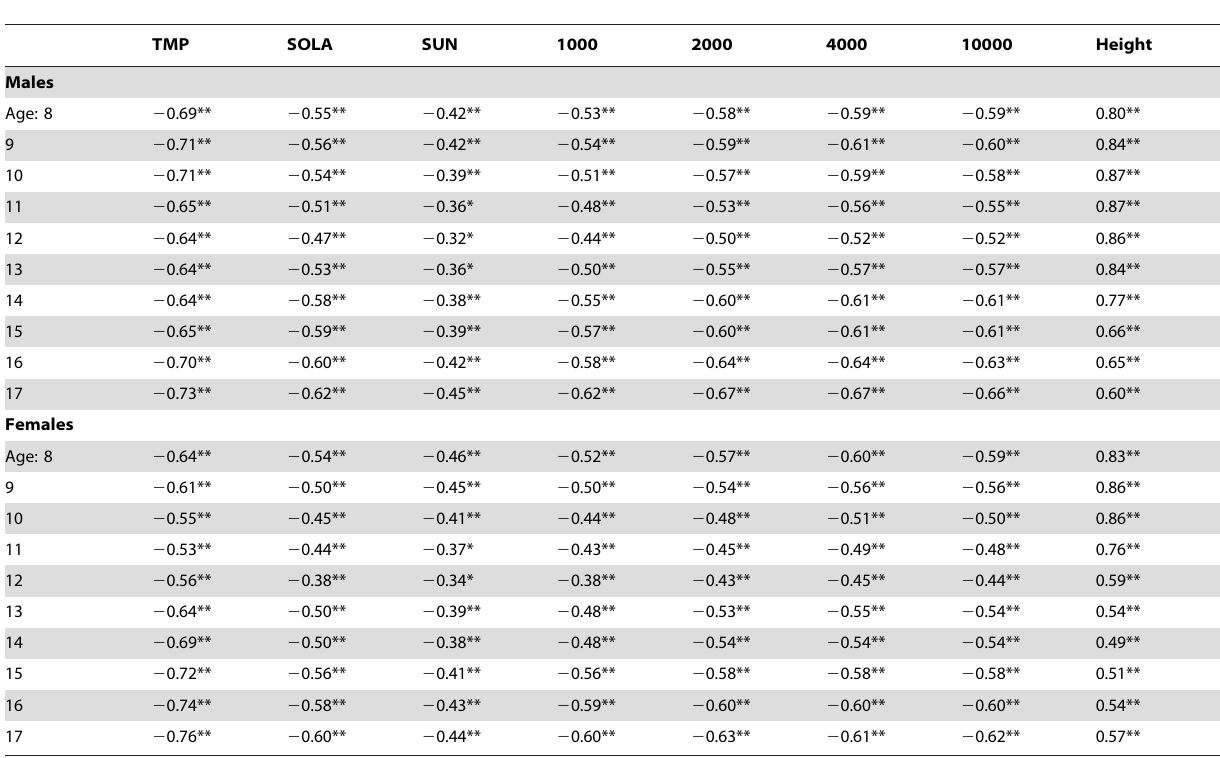
Table 5. Pearson correlation coefficients of the relationship between weight and climatic variables.